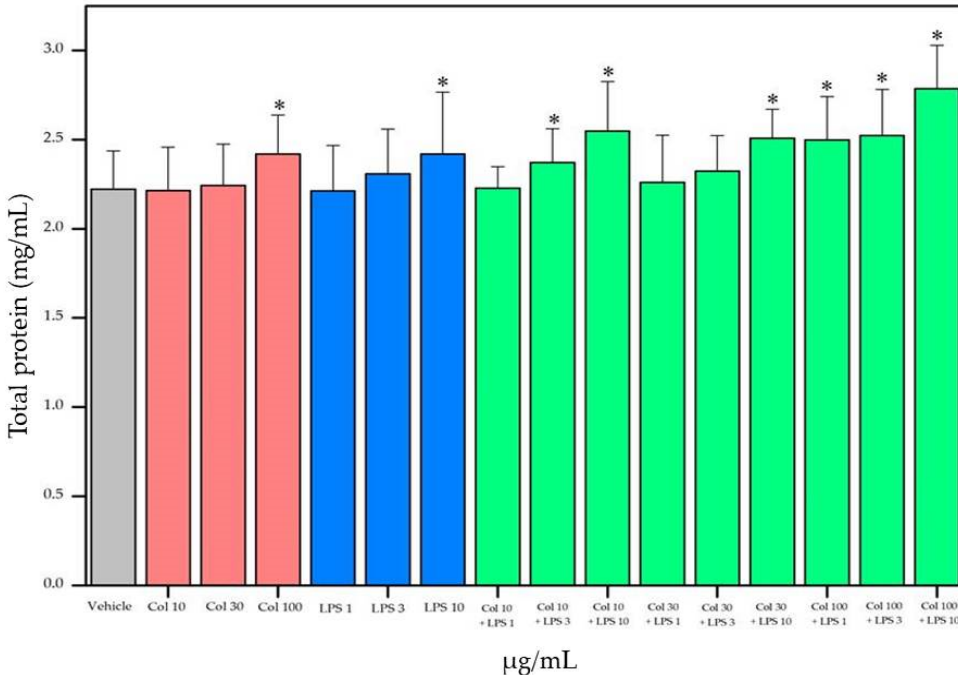
Figure 7. Effect of collagen peptide and LPS on total protein production in supernatant media without RAW 264.7 cells for 48 h. The values are presented as a mean ± standard deviation. The changes were significantly different between the vehicle and test samples, with p < 0.05 (*).